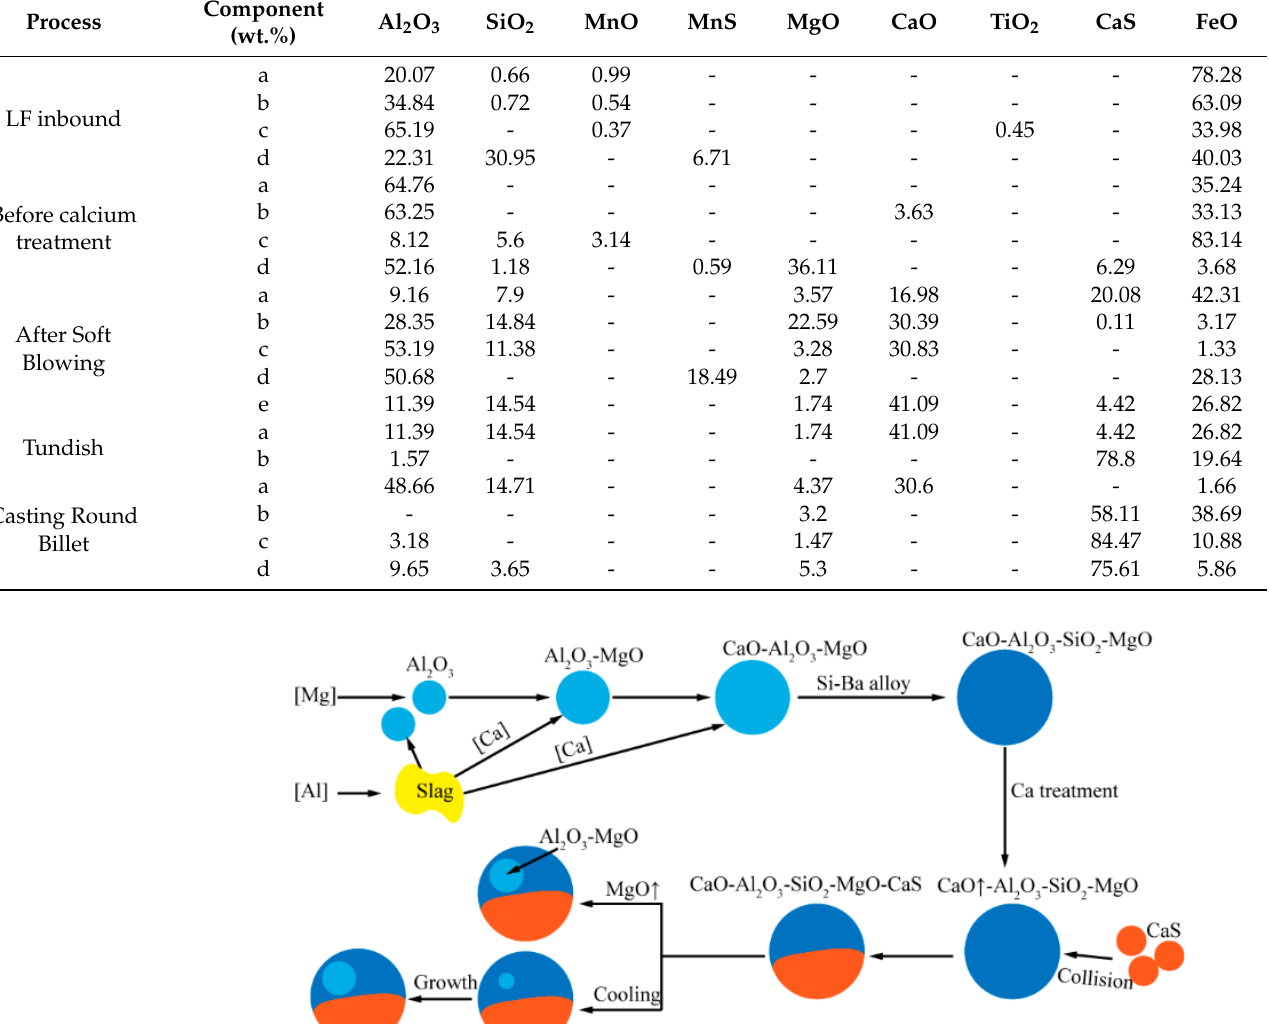
Table 2. Inclusion composition in 27SiMn steel (wt.%).